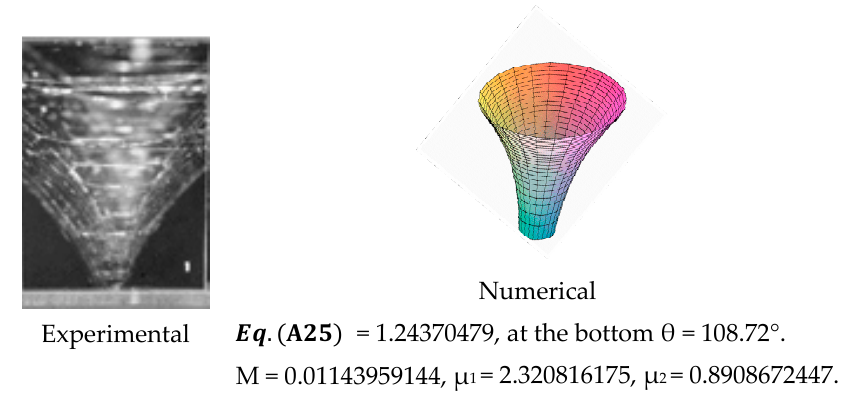
Figure 23. Comparison between experimental [74] and numerical unduloid surfaces.